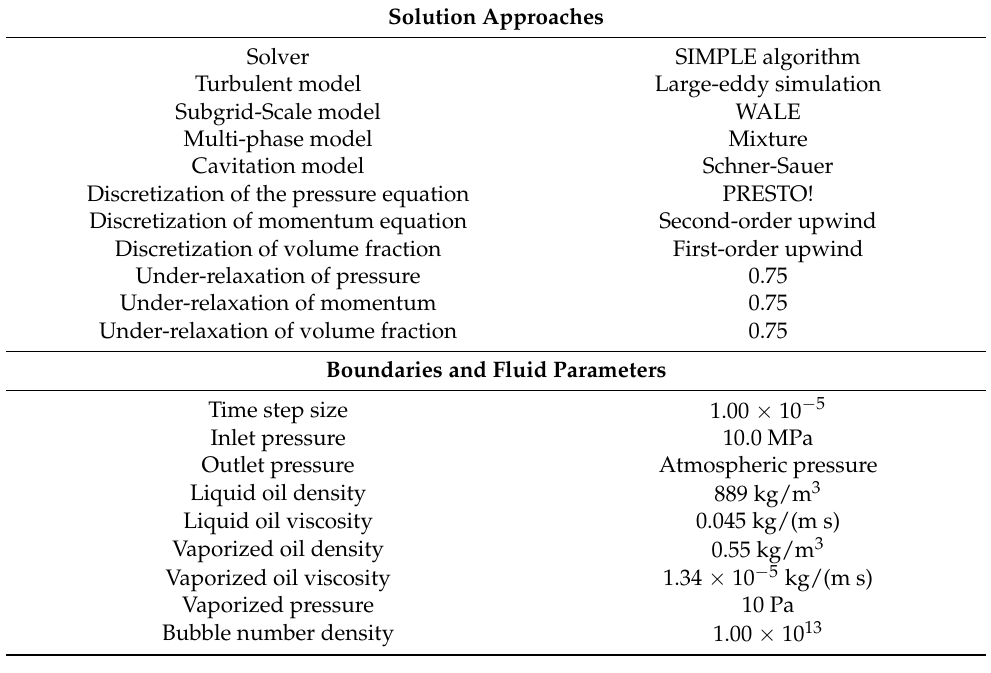
Table 1. Solver and Settings for the